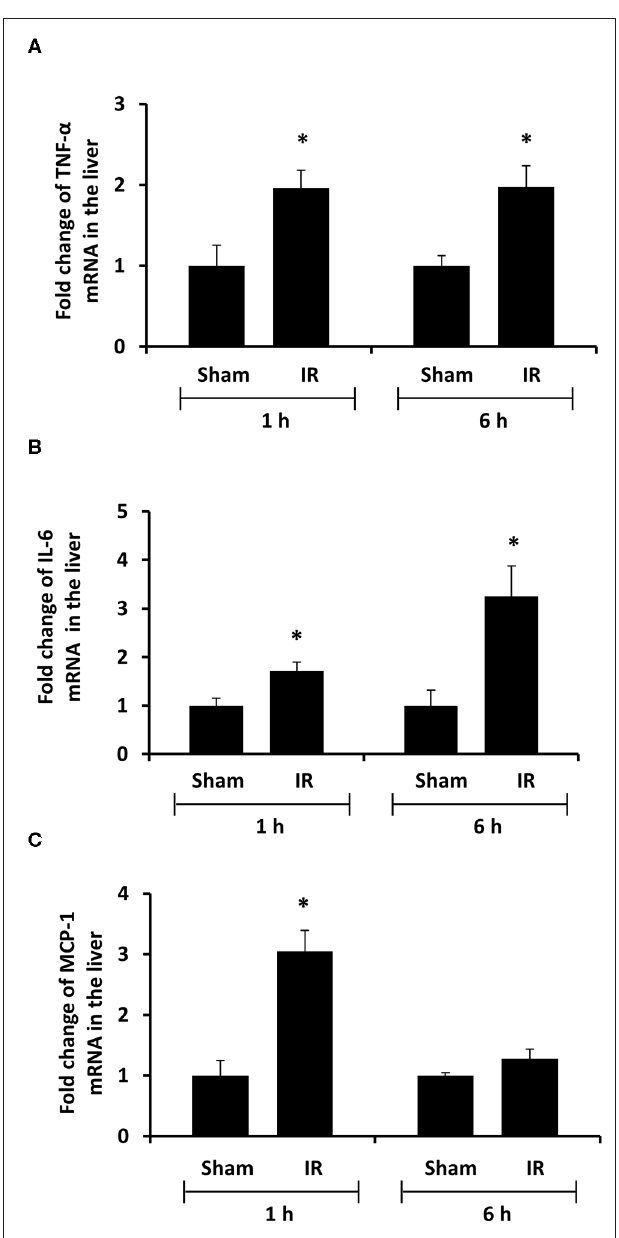
FIGURE 5 | Effect of kidney ischemia-reperfusion on cytokine mRNA expression in the kidney. The left kidney of rats was subjected to 45min ischemia followed by 1 hour (1h) or 6 hours (6h) of reperfusion (IR). As a control, rats were subjected to a sham-operation without inducing ischemia (Sham). The mRNA expressions of TNF- α (A) , IL-6 (B) , and MCP-1 (C) were determined in the kidney by a real-time PCR analysis. Results are expressed as fold change to the Sham ( n = 5 for each group). * p < 0.05 when compared with the value obtained from the sham-operated group.